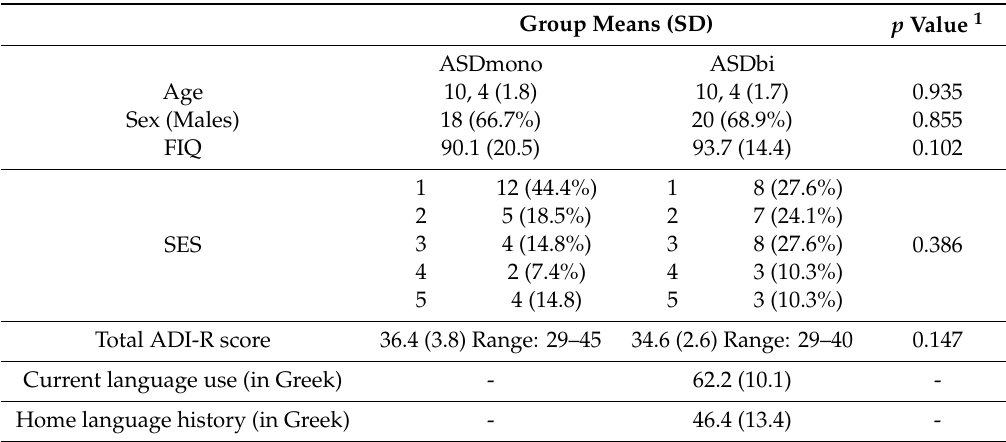
Total ADI-R score 36.4 (3.8) Range: 29–45 0.147 - 62.2